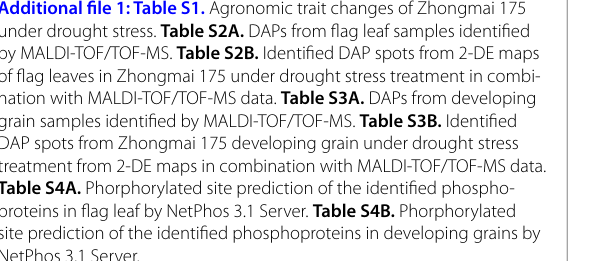
Table S4A. Phorphorylated site prediction of the identified phospho- proteins in flag leaf by NetPhos 3.1 Server. Table S4B. Phorphorylated site prediction of the identified phosphoproteins in developing grains by NetPhos 3.1